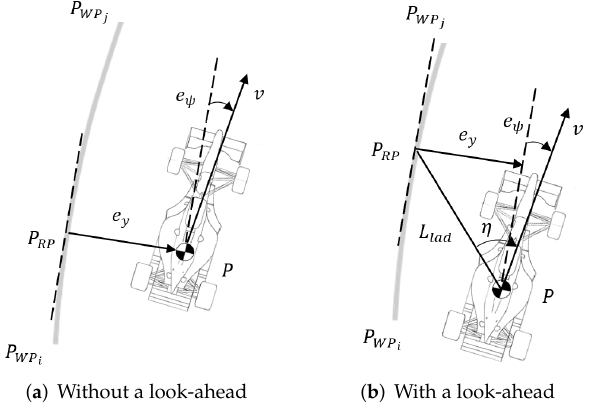
Figure 9. Cross-track and heading